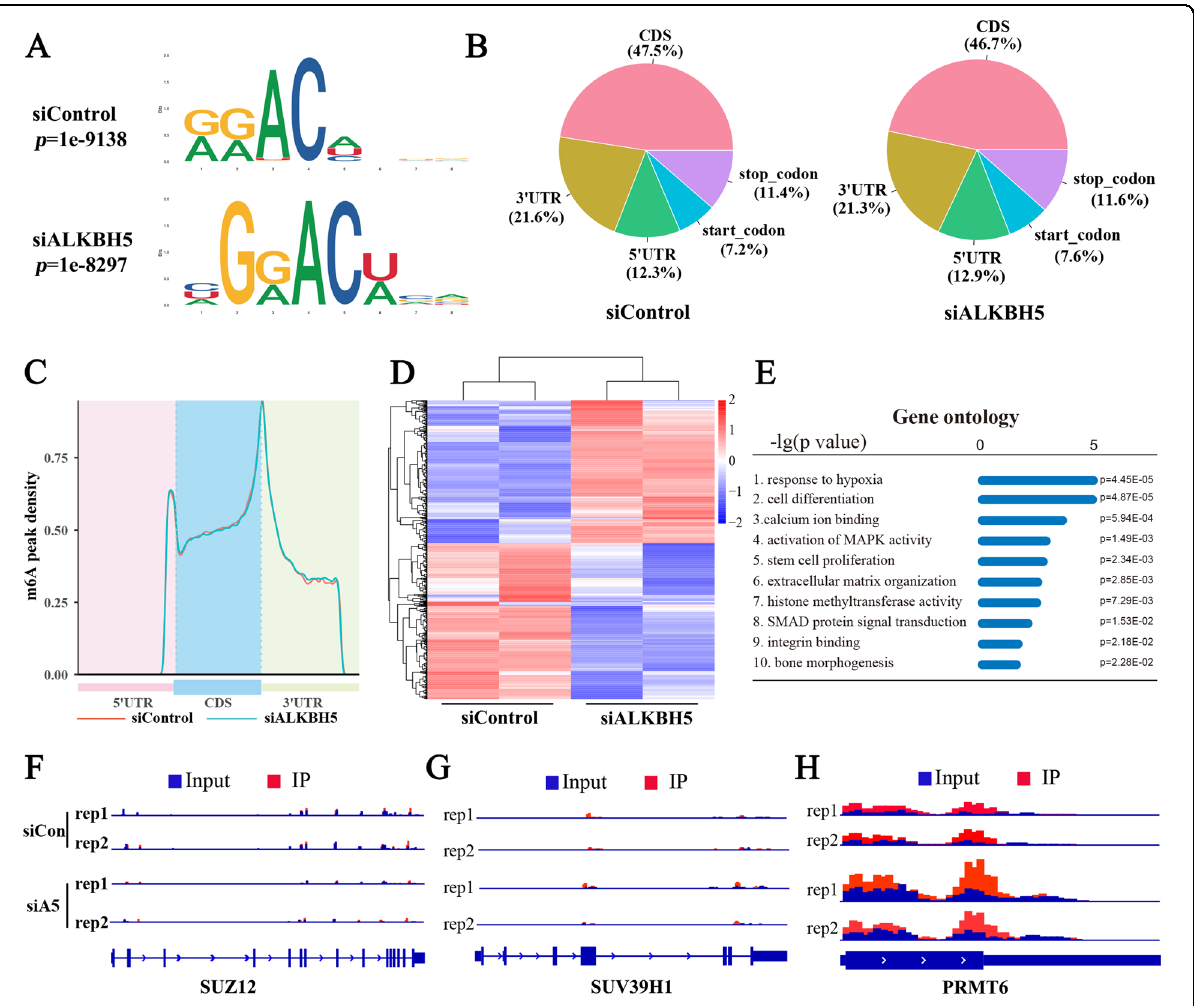
Fig. 4 Whole-transcriptome m 6 A-seq and RNA-seq detection of ALKBH5 downstream regulatory genes. A Speci fi c motif sequences of the siControl and siALKBH5 groups (two biological repeats per group). B Proportion of m 6 A peak distribution in the 5 ′ -UTR, start codon, CDS, stop codon or 3 ′ -UTR across the entire set of mRNA transcripts. C Density distribution of m 6 A peaks across mRNA transcripts. D Heatmap of genes with signi fi cantly different expression between the siControl and siALKBH5 groups. siCon-1 and siCon-2 are biological repeats; E GO enrichment analysis of differentially expressed genes. F – H IGV software analysis of the m 6 A peaks of SUZ12 , SUV39H1 , and PRMT6